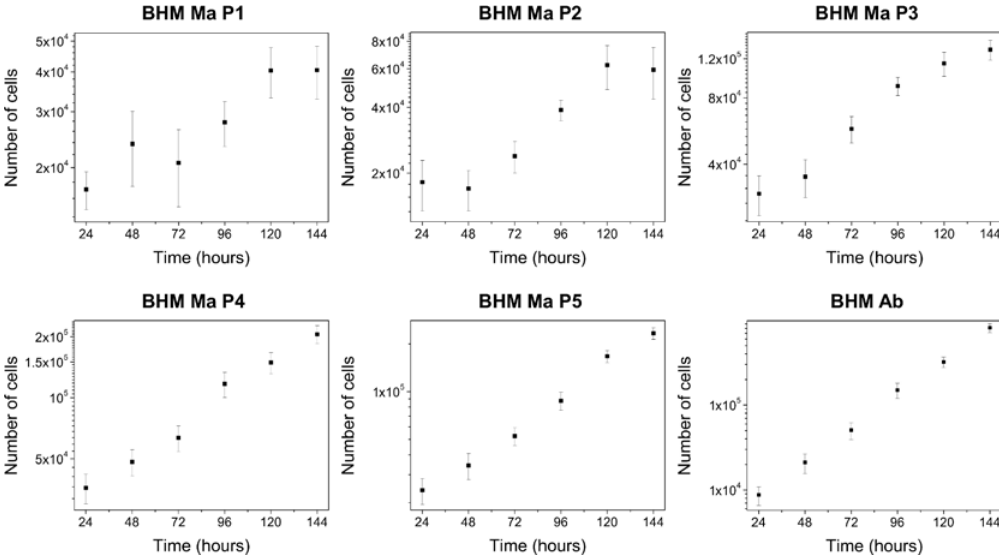
Figure 2. Growth curves of BHM cells presented in a logarithmic scale. Note that BHM Ma cells from first passage have a very uneven distribution with high dispersion of the data, which over consecutive passages becomes more linear and ordered. On the other hand, BHM Ab cells show a very stable growth within the time frame of the experiment. Error bars represent s.d.